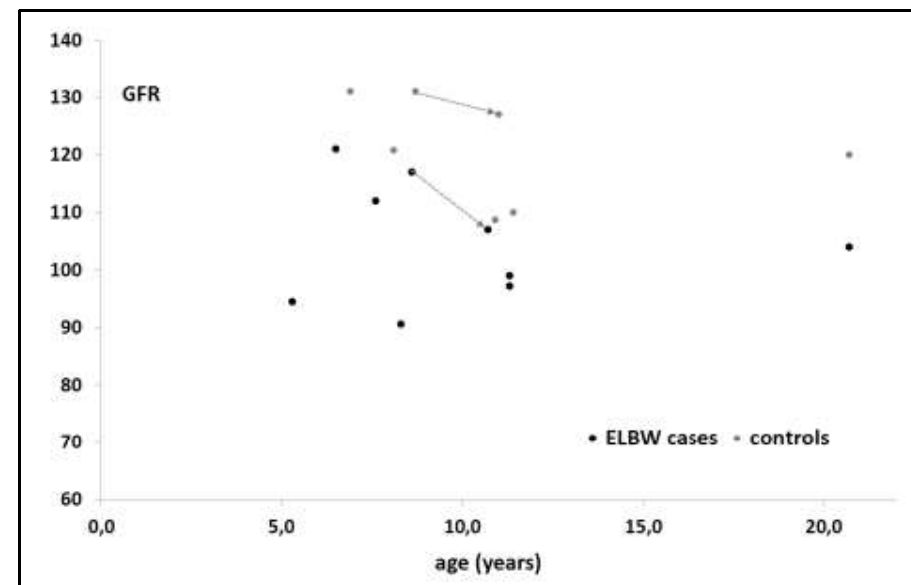
Figure 2. Mean or median (estimated) glomerular filtration rate (eGFR) in the 6 case-control studies over age (years) [12–17]. The arrows connect the same cohort assessed at the age of 7 and 11 years respectively [17,18] (ELBW: extreme low birth weight).